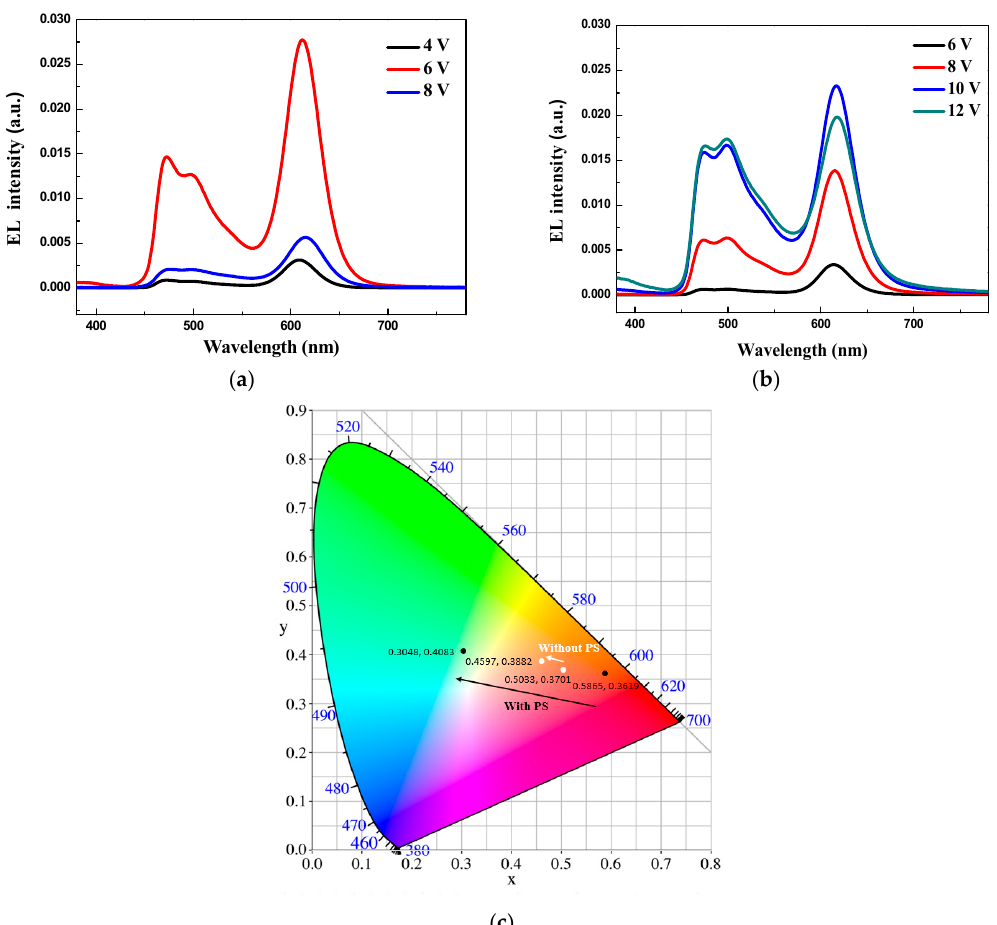
Figure 6. Voltage-dependent spectra of hybrid EL devices: ( a ) without PS and ( b ) with PS. ( c ) Shifts in Commission Internationale de l’Eclairage (CIE) coordinates of hybrid EL devices as applied voltage increases.